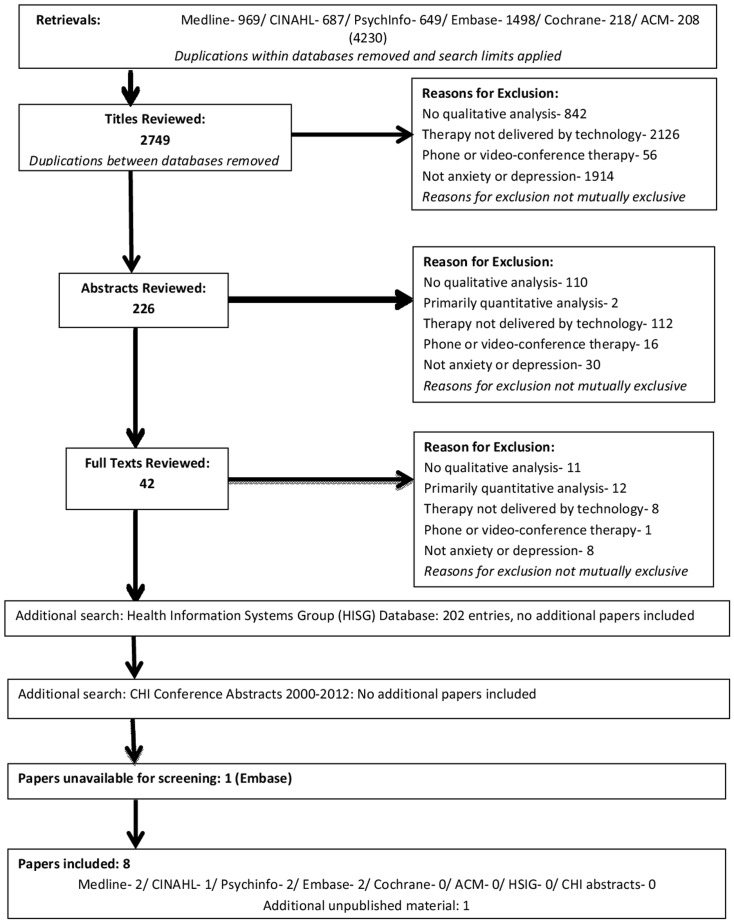
PRISMA flowchart.